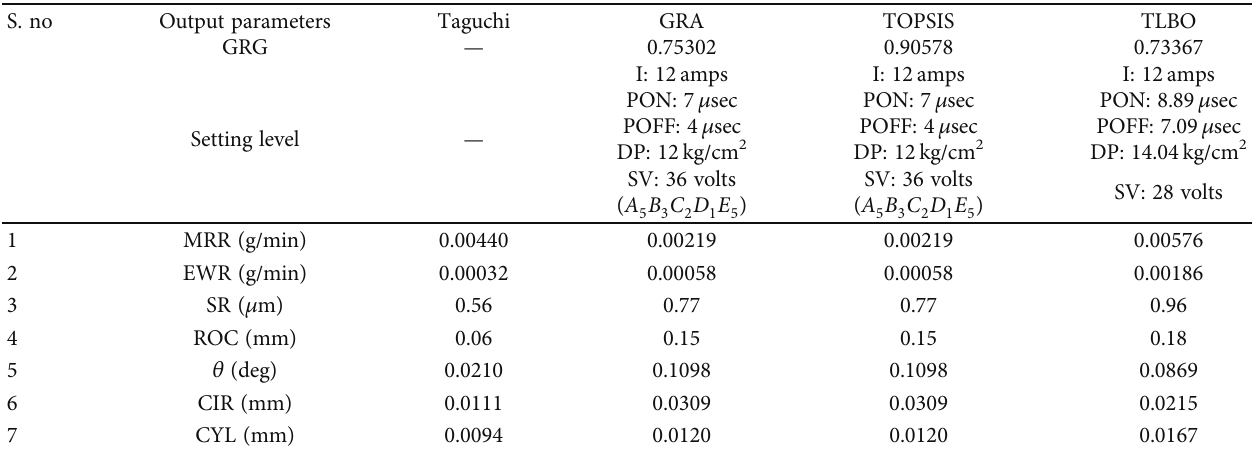
Figure 6: SEM micrographs of machined Si Table 13: Comparison of various optimization